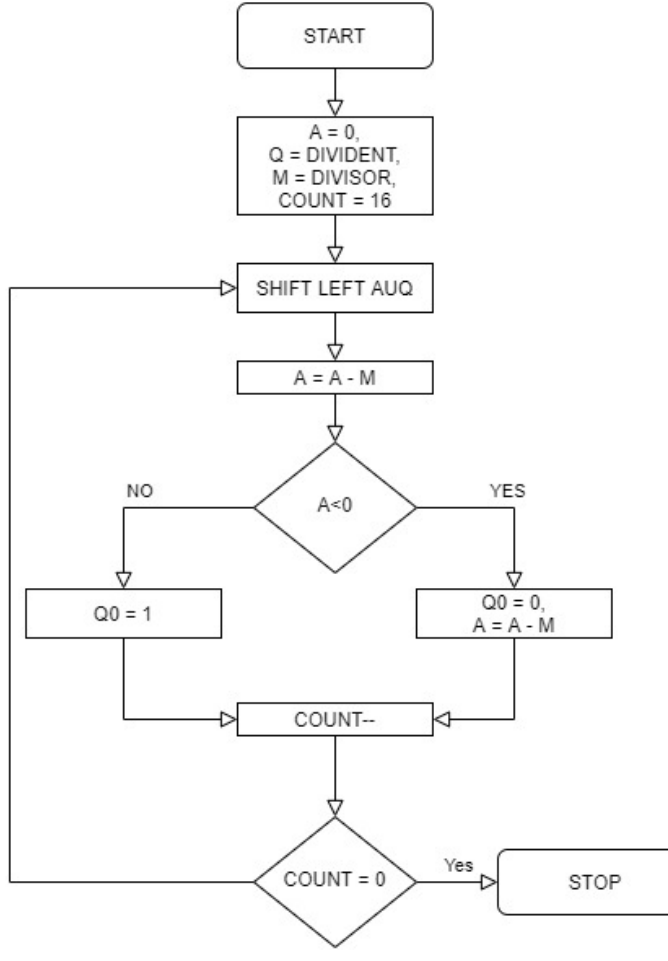
Figure 11. Division